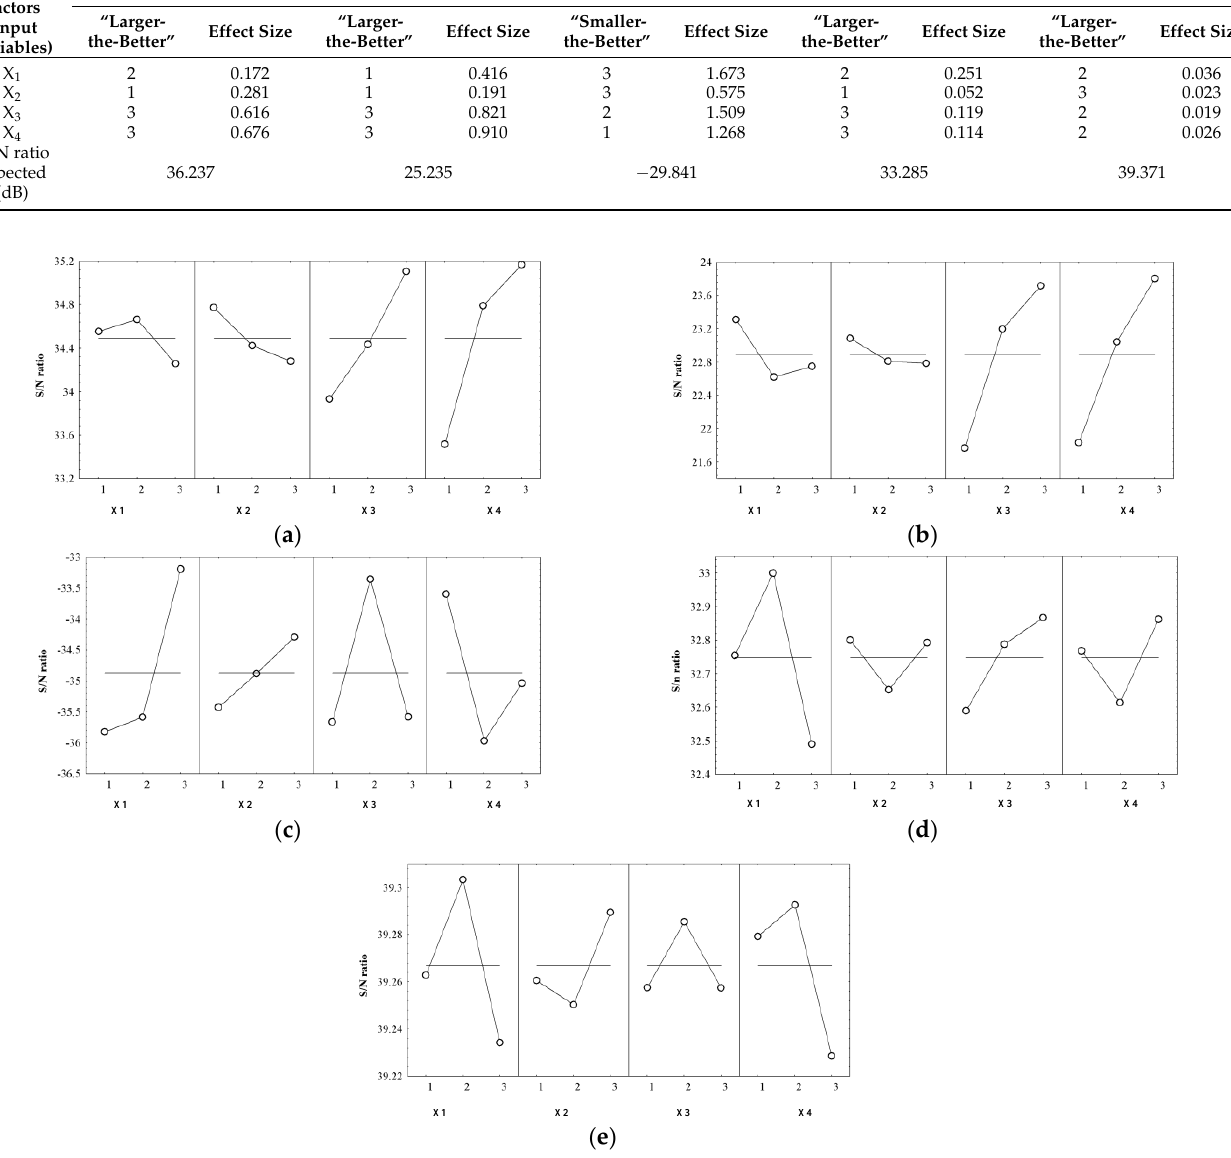
Figure 10. Control factors’ effects on S/N for ( a ) WCW (g/L); ( b ) DCW (g); ( c ) CA (°); ( d ) PC (%); and ( e ) DS (%). By applying the Taguchi technique as the final stage of the optimization process, we selected four cultivation parameter combinations which led to different biomass charac- teristics and were minimally affected by the noise factors. From these cultivation condi- tion combinations, three were not included in the initial fractional Taguchi experimental